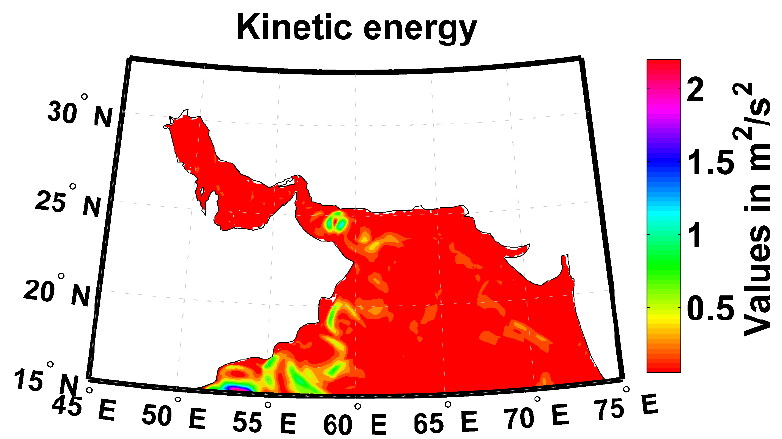
Figure 17. Mean kinetic energy.